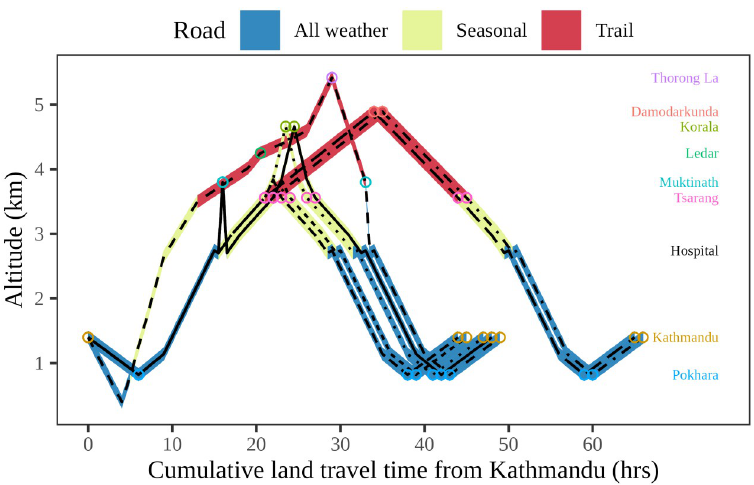
Fig 1. Various travelling routes used by AMS patients visiting the emergency ward of Mustang district hospital. Each line represents a unique travelling route. Important locations in routes are plotted against their respective elevations in the y-axis. The cumulative land-travel time on x-axis is the sum of the average land-travel time from Kathmandu, whether by bus, jeep, or on foot, depending on the road’s characteristics. All-weather roads are those that have public bus routes. On seasonal roads, off-road four-wheelers provide transit most months of the year except during snowfall and heavy rain. On trails, walking is the only mode of travel. Among major routes within Mustang, all except for Damodar Kunda (4890 m) are passable with a motorized vehicle at least seasonally. Except for the route from Manang through Thorong La, all other routes pass the Mustang district hospital during both ascent and descent. Trekkers travelling in Thorong La route pass hospital only during the